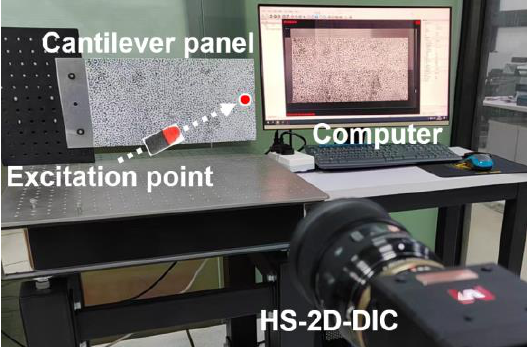
Figure 8. A photograph of the cantilever aluminum panel vibration experiment.